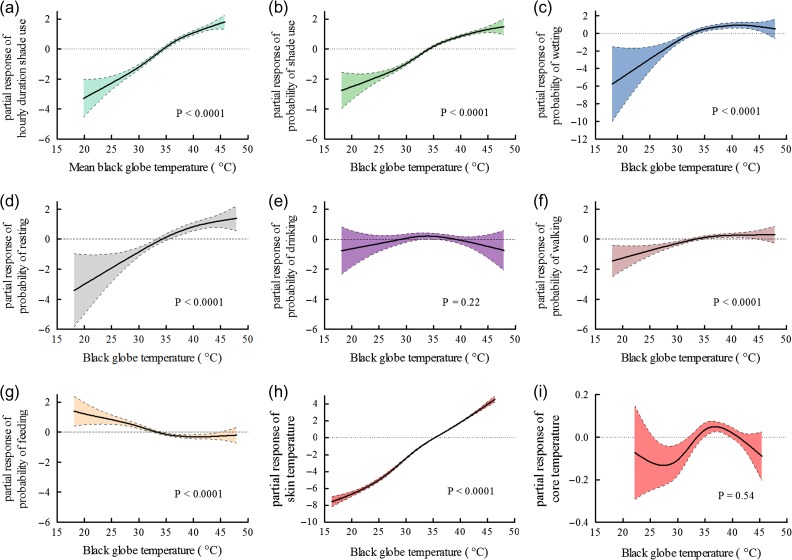
Outcomes of generalized additive mixed model analysis for recorded behaviours (a–g), skin (h) and core temperatures (i) dependent on black globe temperature in selected best approximate models. The y-axes are partial residual responses plotted on the scale of the linear predictor; they represent how the response would deviate from the predictions of a model that assumed the response was independent of the x-axis variable, here black globe temperature. Shaded areas and dashed lines represent 95% confidence intervals.